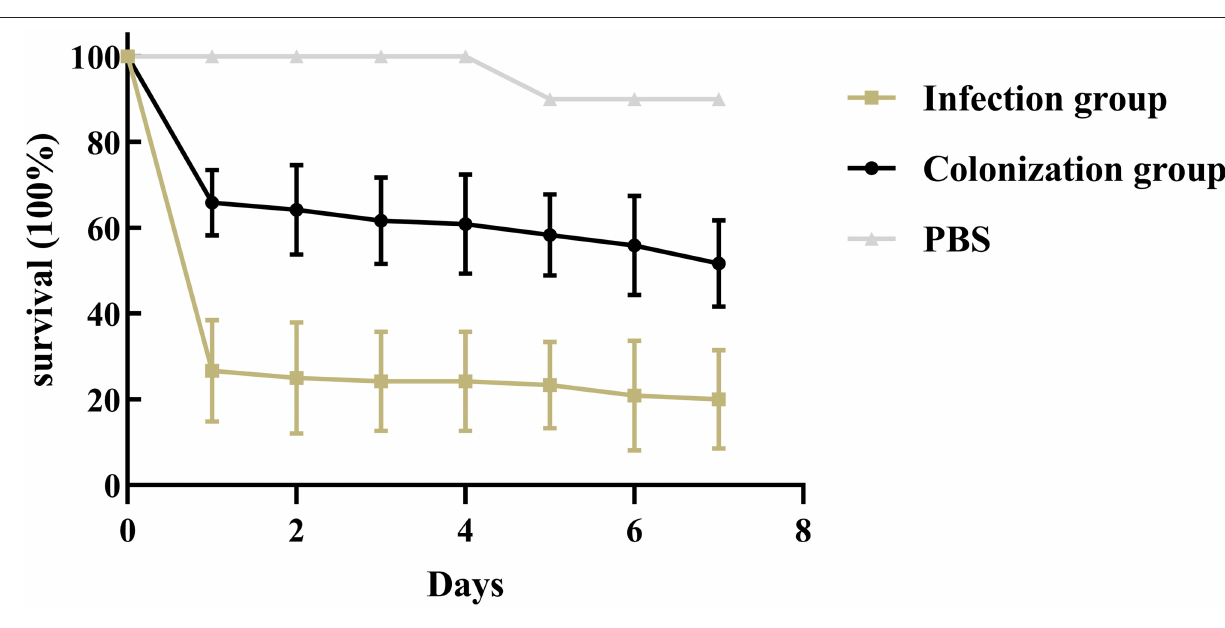
( P < 0.05). Nevertheless, there was no significant difference in the production of capsular polysaccharides and antiserum killing ability of strains in infection group and colonization